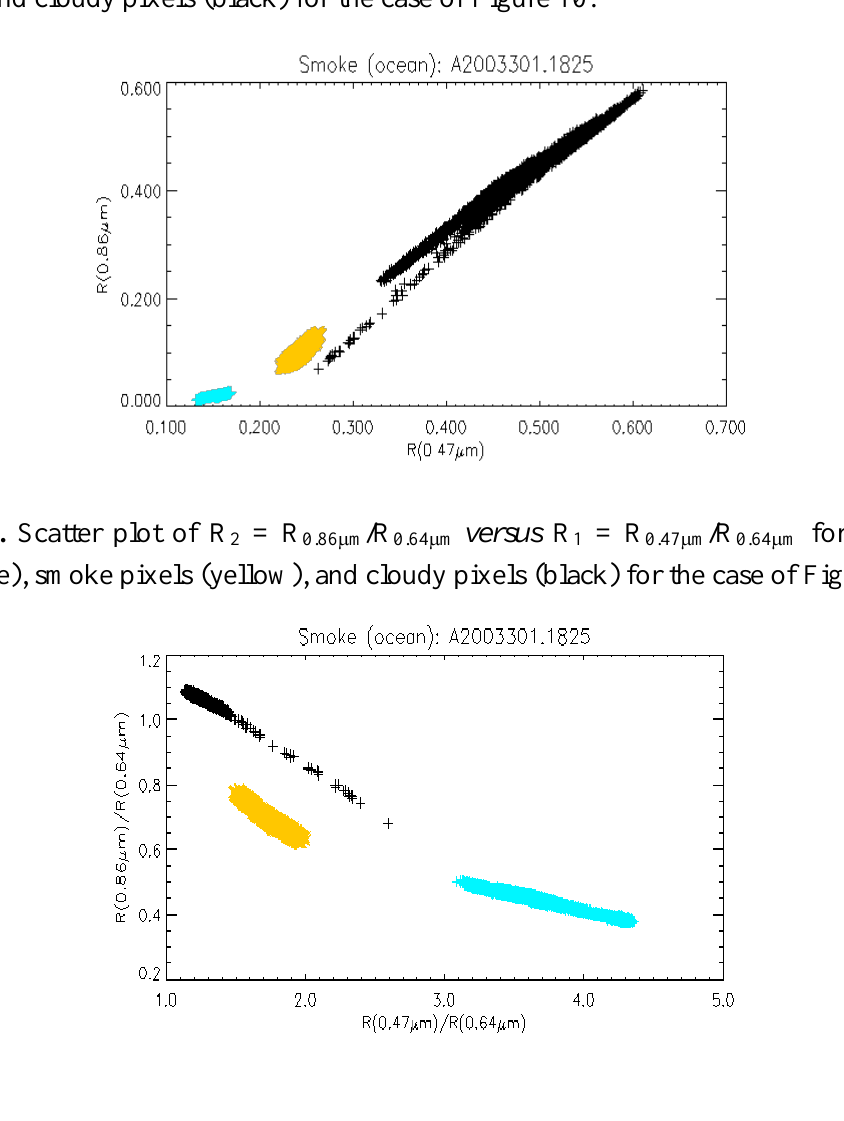
versus R for clear-sky pixels (blue), smoke pixels 0.86  m 0.47  m